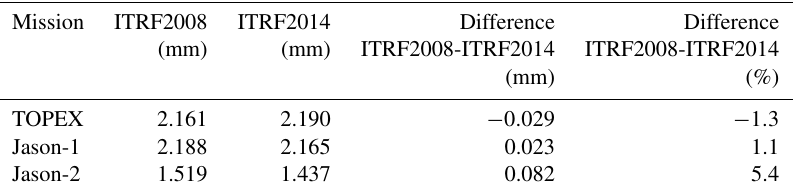
Table 6. Standard deviations of geographically correlated mean SSH errors obtained using orbits of three satellites based on ITRF2008 and ITRF20014 and their differences (positive values indicate improvements obtained for the orbits computed using